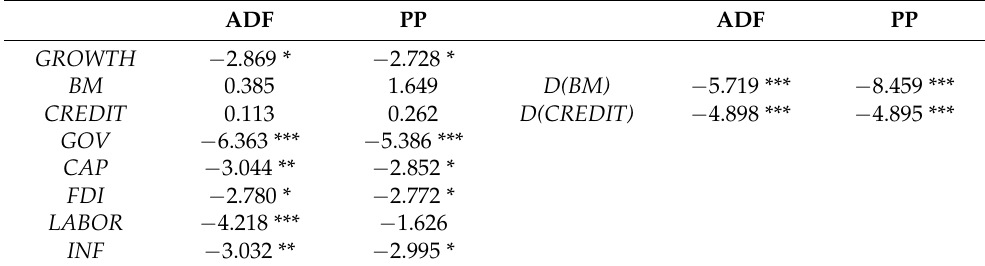
Table 1. Stationary test